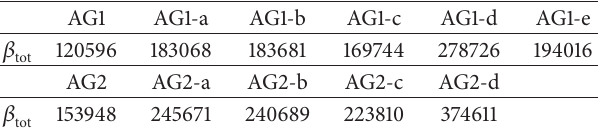
Table 6: Hyperpolarizability of designed dyes (AG1-X and AG2-X) in solvent